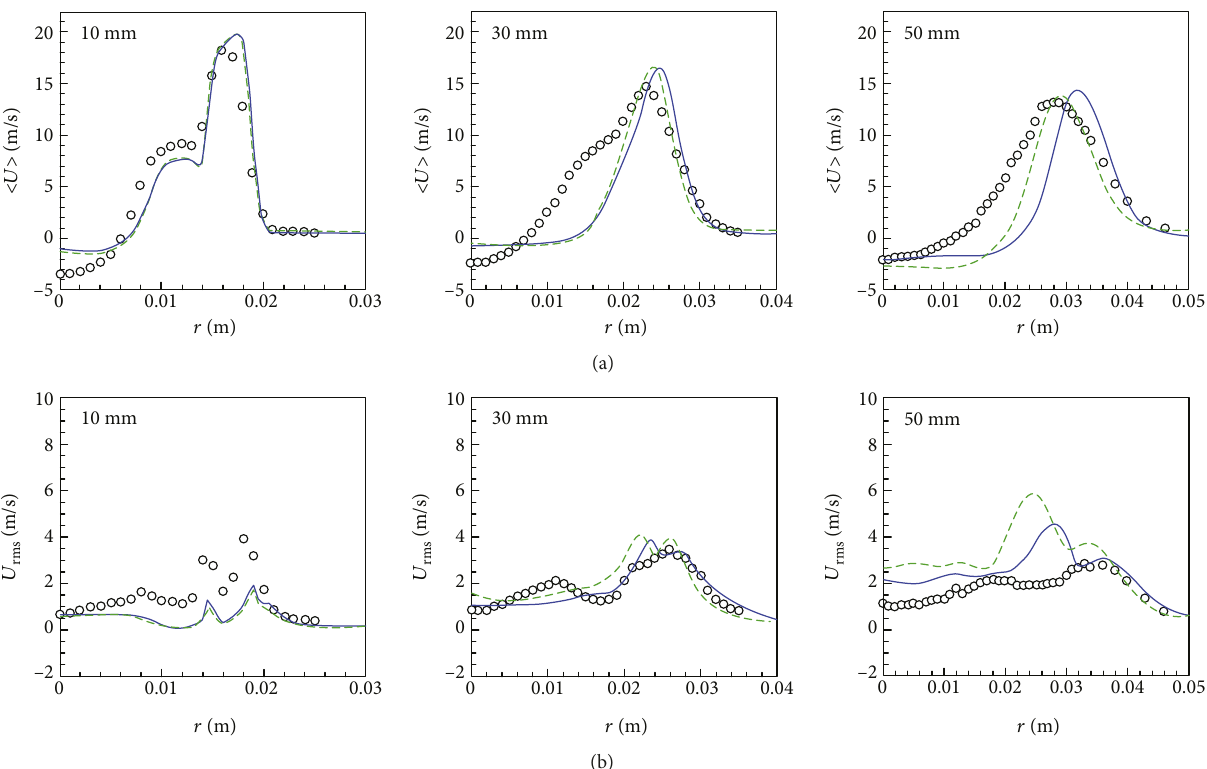
Figure 7: Comparison of mean (a) and rms (b) axial velocity at Δ X = 10mm , 30mm, and 50 mm (circles, experimental results; dash line, Mech I prediction; solid line, Mech II prediction).